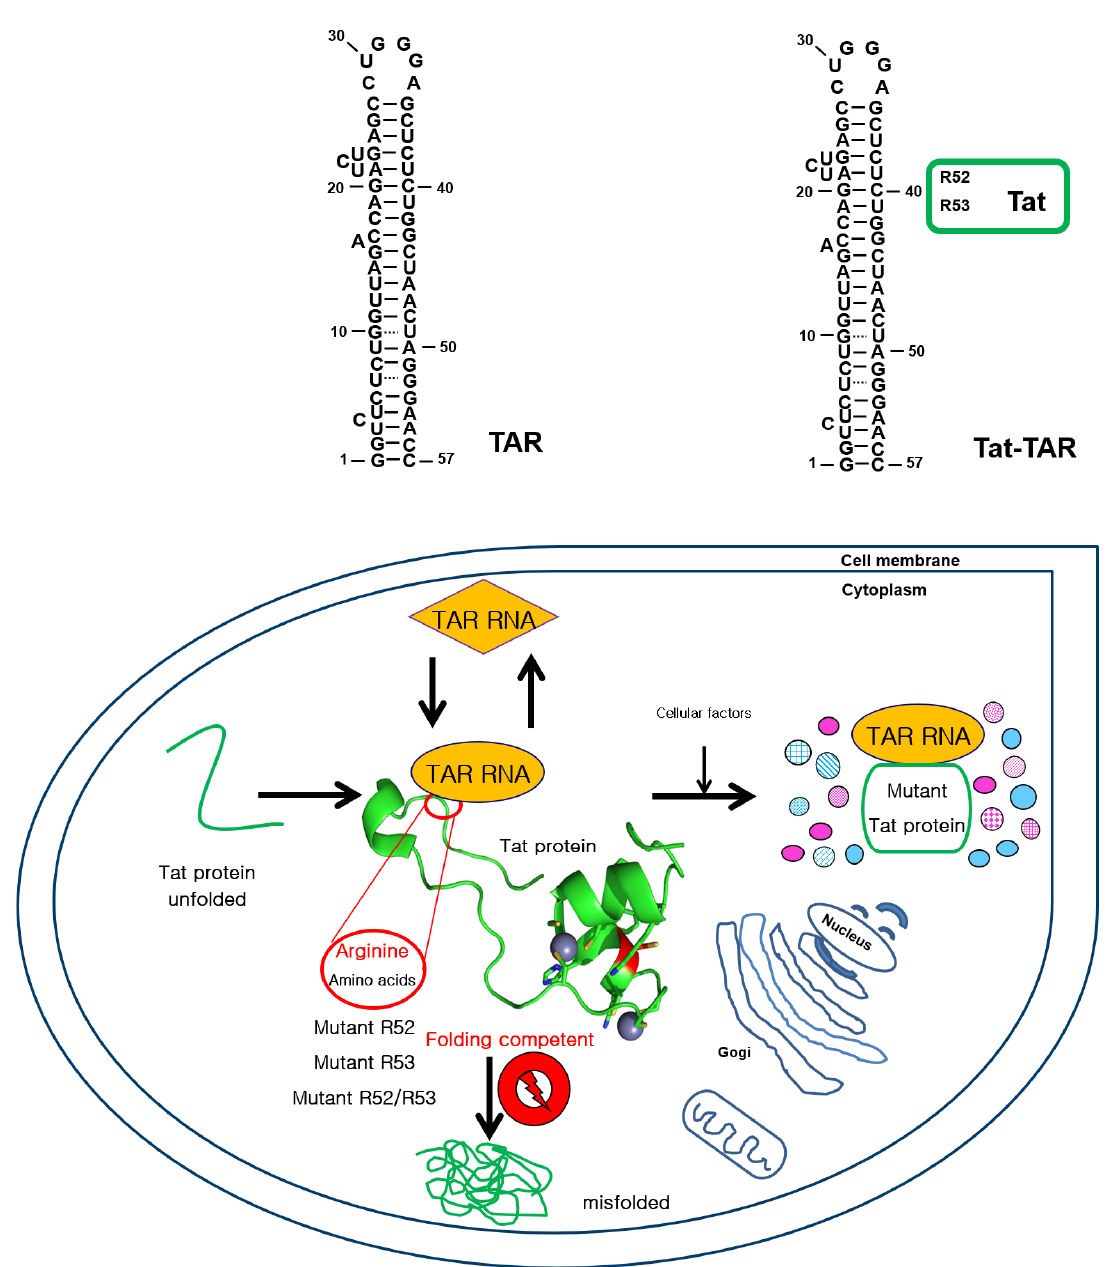
Figure 1. The TAR RNA sequence and chaperna for a single-arginine residue mutant Tat refolding. This figure shows TAR RNA as a molecular chaperone for mutant Tat protein. Tat binds to TAR, which is a highly structured element that is ‘folding competent’ and that specifically interacts with arginine residues. The TAR RNA sequence originates from the complete genome of HIV-1. It comprises 57 base pairs and a stem–loop structure. Two selected arginine residues, R52 and R53, were each selected from the HIV Tat protein for single-point mutation by substitution with alanine. All the mutants of Tat can interact with cellular factors—e.g., cyclin T1 (pink) and P-TEFb (blue)—and can be further regulated by its TAR RNA. The presence of hydrophobic residues, such as alanine, on the interior of a mutant Tat with reduced refolding ability did not lead to a further reduction in this ability, indicating that a single arginine residue is associated with R52Tat-binding TAR RNA. A single